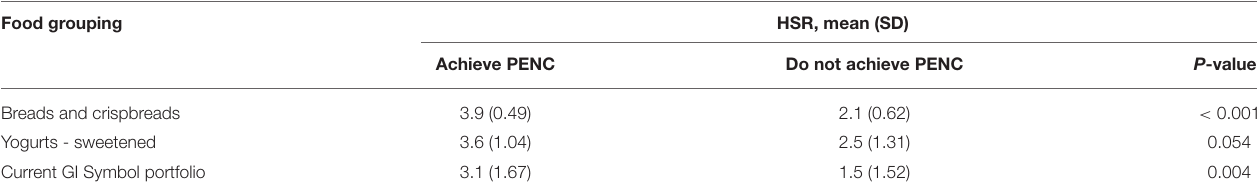
TABLE 3 | HSR assessment of updated GI Symbol PENC for selected FoodSwitch products within the ‘breads and crispbreads’ and ‘yogurt – sweetened’ food categories, and the current GI Symbol portfolio of foods. Food